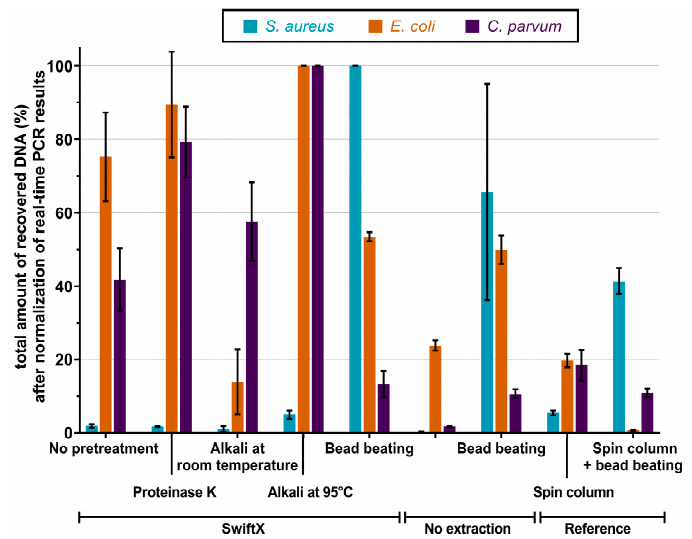
Figure 2. Performance of various extraction protocols with and without pre-treatment. The percentage of recovered DNA for different pre-treatment protocols was measured after the normalization of real-time PCR results. Cell suspension of 10 7 bacterial cells of S. aureus , 10 8 bacterial cells of E. coli or 10 6 oocysts of C. parvum was pelleted and extracted. DNA was measured by real-time PCR. The highest percentage of recovered DNA was achieved using SwiftX with bead beating in the case of S. aureus . SwiftX with proteinase K or alkaline treatment for E. coli and C. parvum revealed the best DNA recovery rate.